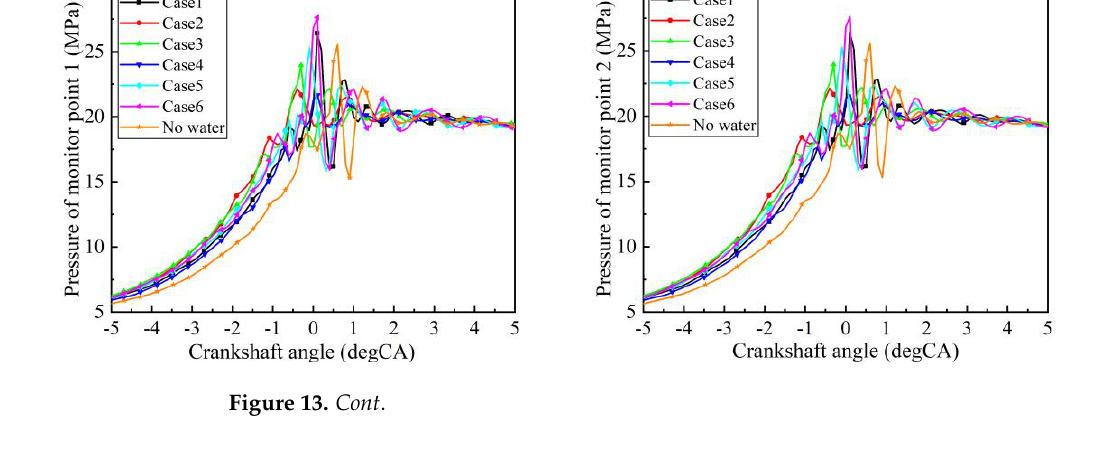
Figure 12. ( a ) Average pressure, ( b ) average temperature, ( c ) ignition delay and combustion phase in different water injection cases (CR = 10.3, ignition time = − 14 degCA).